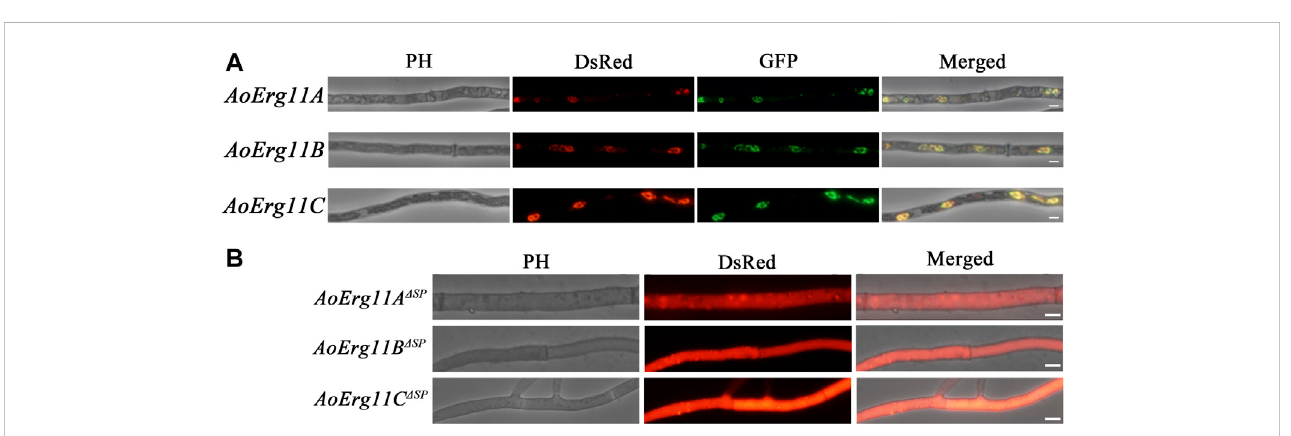
FIGURE 3 Subcellular localization ofAoErg11s. (A) Co-localizationof AoErg11s-DsRed withendoplasmicreticulum.Themyceliaof A.oryzae 3.042 Δ pyrG wereco- transformedwith AoErg11s-DsRed and AoClxA-GFP vectors.Lefttoright:phasecontrast, fl uorescentimageofDsRed,GFP,andmergedimageofDsRed,GFP and phase contrast. (B) The mycelium of A. oryzae 3.042 Δ pyrG transformed with AoErg11 Δ SP s-DsRed . Left to right: phase contrast, fl uorescent image of DsRed, and merged image of DsRed and phase contrast. The scale in the fi gure represents 5